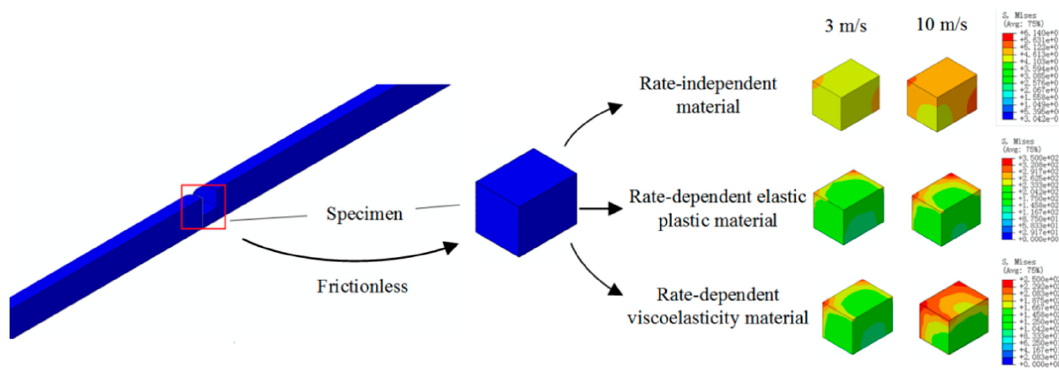
Figure 10. Comparison of the reflected and transmitted waves for cylinder specimen and cubic specimen with rate-dependent viscoelasticity material (u = 0). ( a ) Impact velocity of 3 m/s, ( b ) impact velocity of 10 m/s.